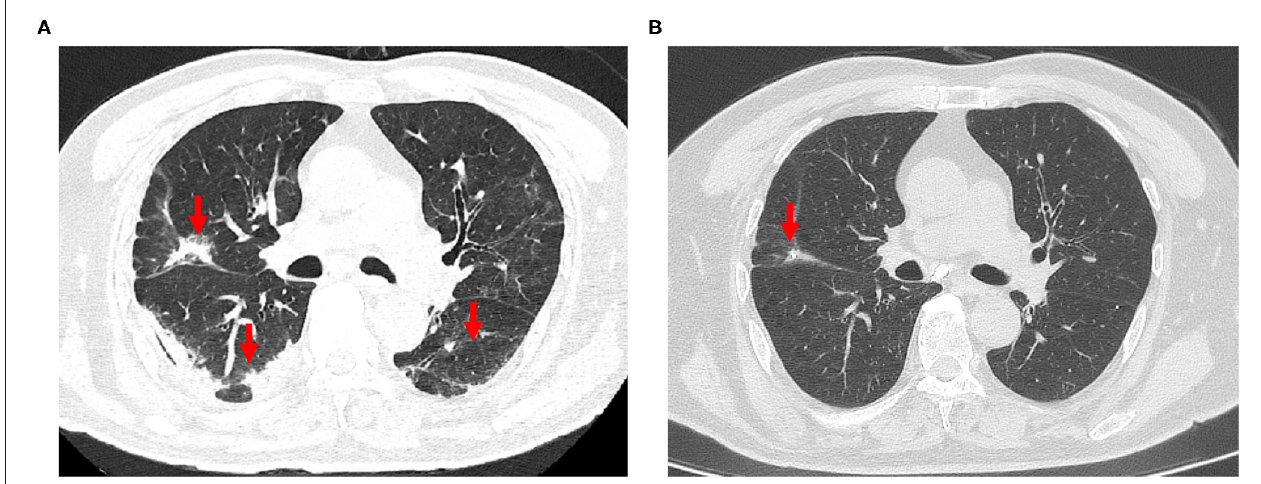
FIGURE 3 | (A) The chest CT scan of a 79-year-old man with severe COVID-19 on admission, revealing diffuse ground-glass opacity and consolidation in the lungs. (B) Reexamination of chest CT at 10 months after discharge, showing that the ground glass opacities and consolidation had completely disappeared, and mild pulmonary fibrosis were